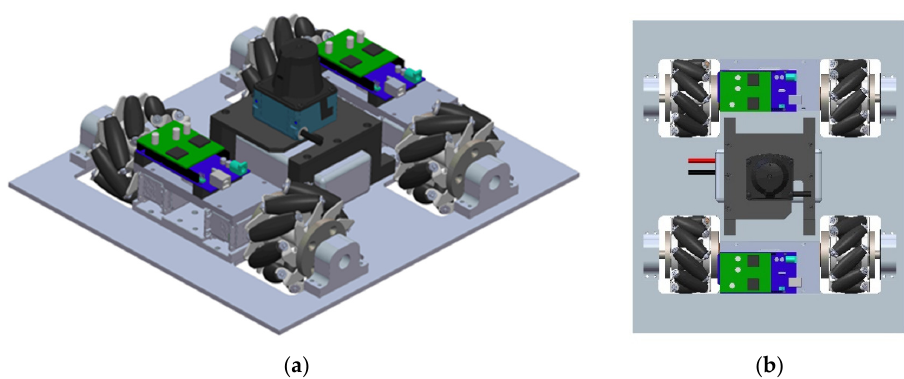
Figure 4. The 3D CAD model of the mobile robot: ( a ) first view; ( b ) second view.